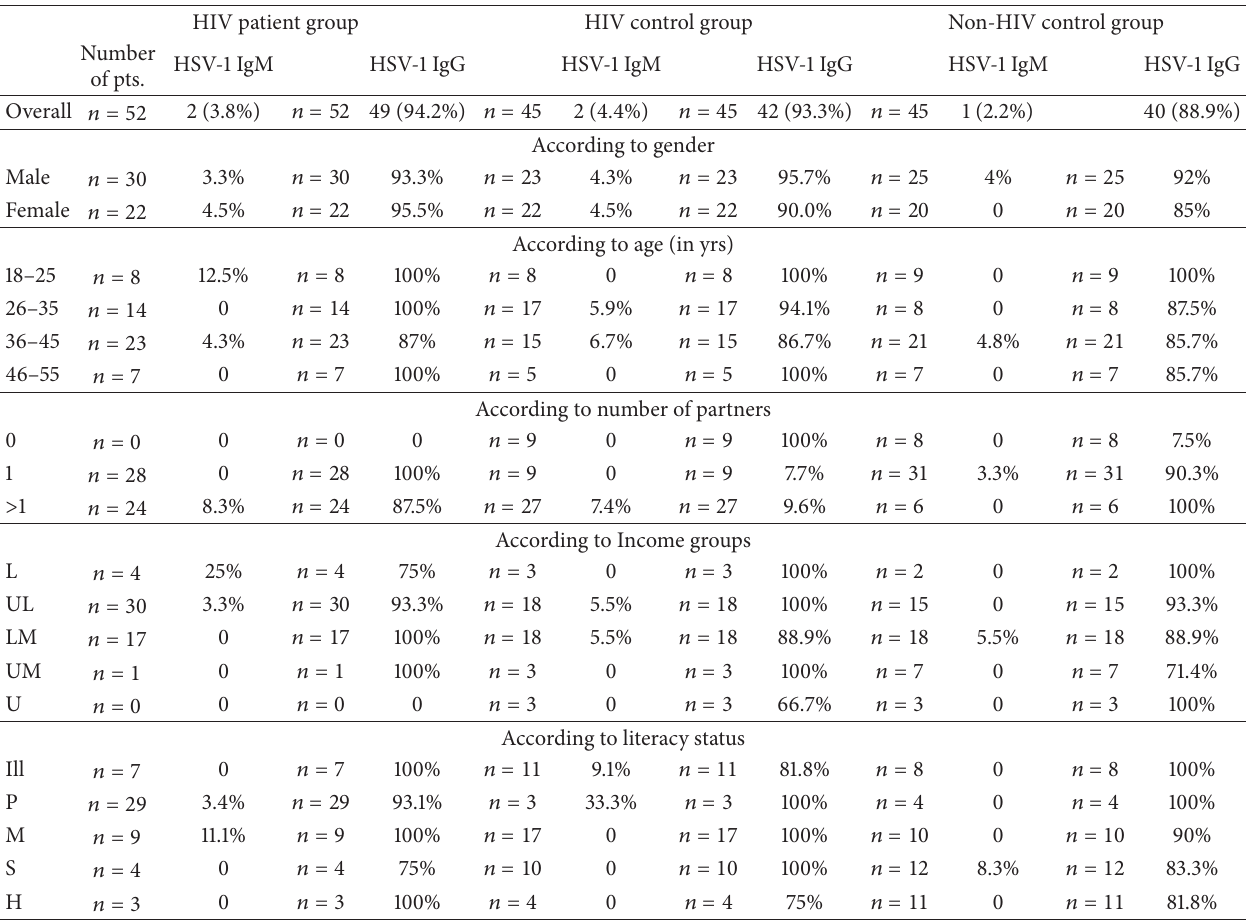
Table 2: Seroprevalence of HSV-1 IgM and HSV-1 IgG